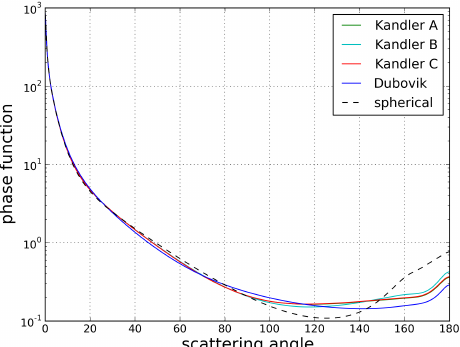
Figure 1. Phase functions at 0.55µm for the mixture of the mineral components after the aerosol type “desert”, under the assumption of spherical mineral particles and for mineral particles with various aspect ratio distributions (see text for